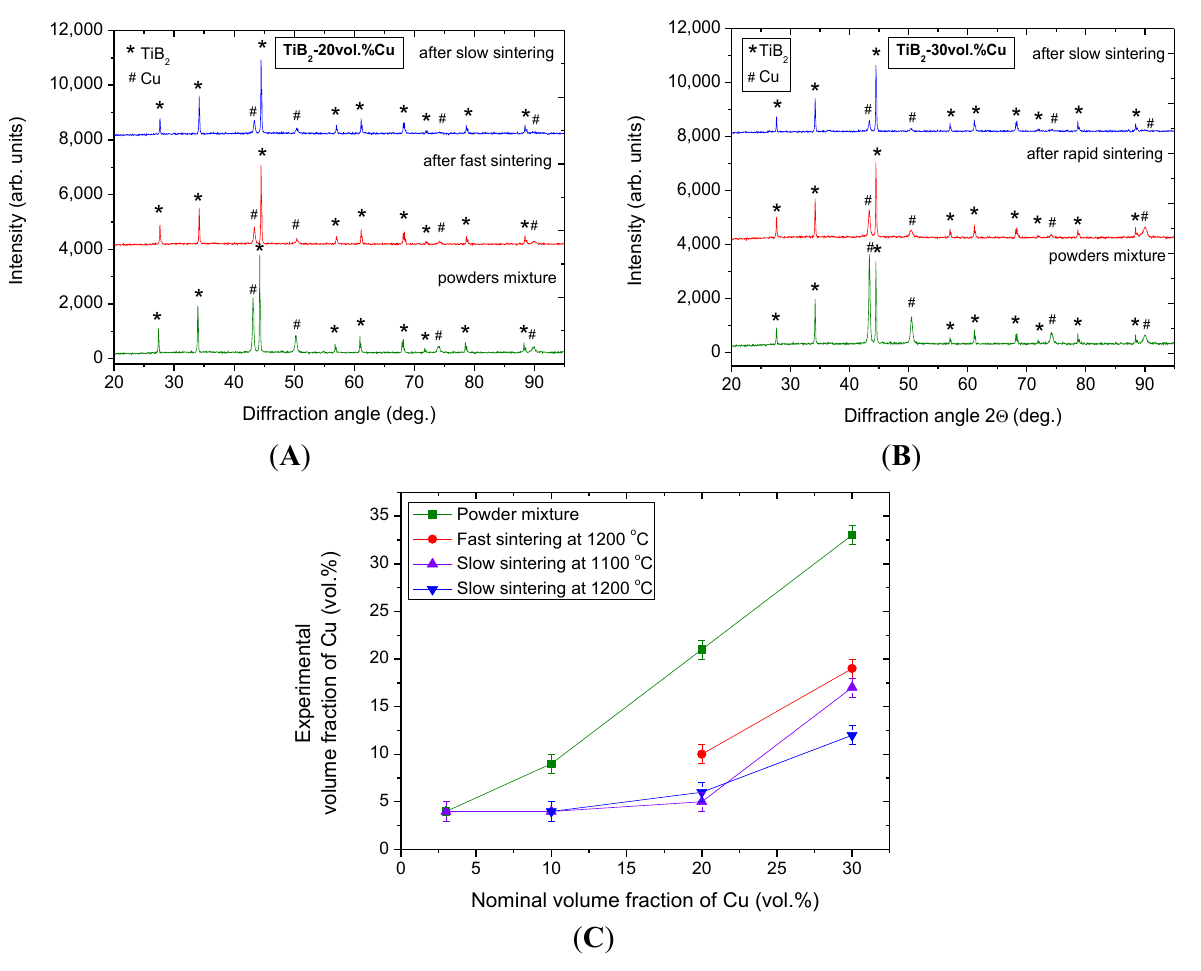
point; and swelling, which affected Cu drops. The Cu drops falling down from the graphite die were observed in the temperature interval from 1030 to 1180 °C (Figure 2). Figure 7. The X-ray diffraction (XRD) patterns for cermets sintered at 1200 °C and their initial powders mixture: ( A ) TiB 2 -20 vol. % Cu cermet; ( B ) TiB 2 -30 vol. % Cu cermet; ( C ) graph representing the experimental volume fraction of Cu (determined by Rietveld method) confronted to nominal Cu content.